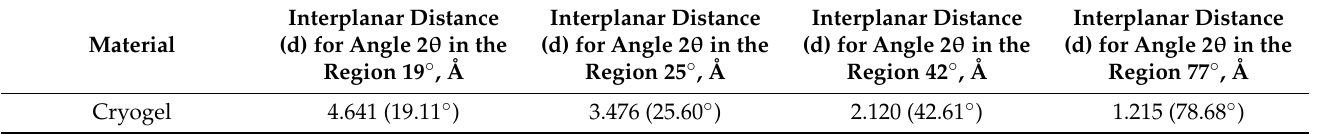
Table 2. Interplanar distances for the final